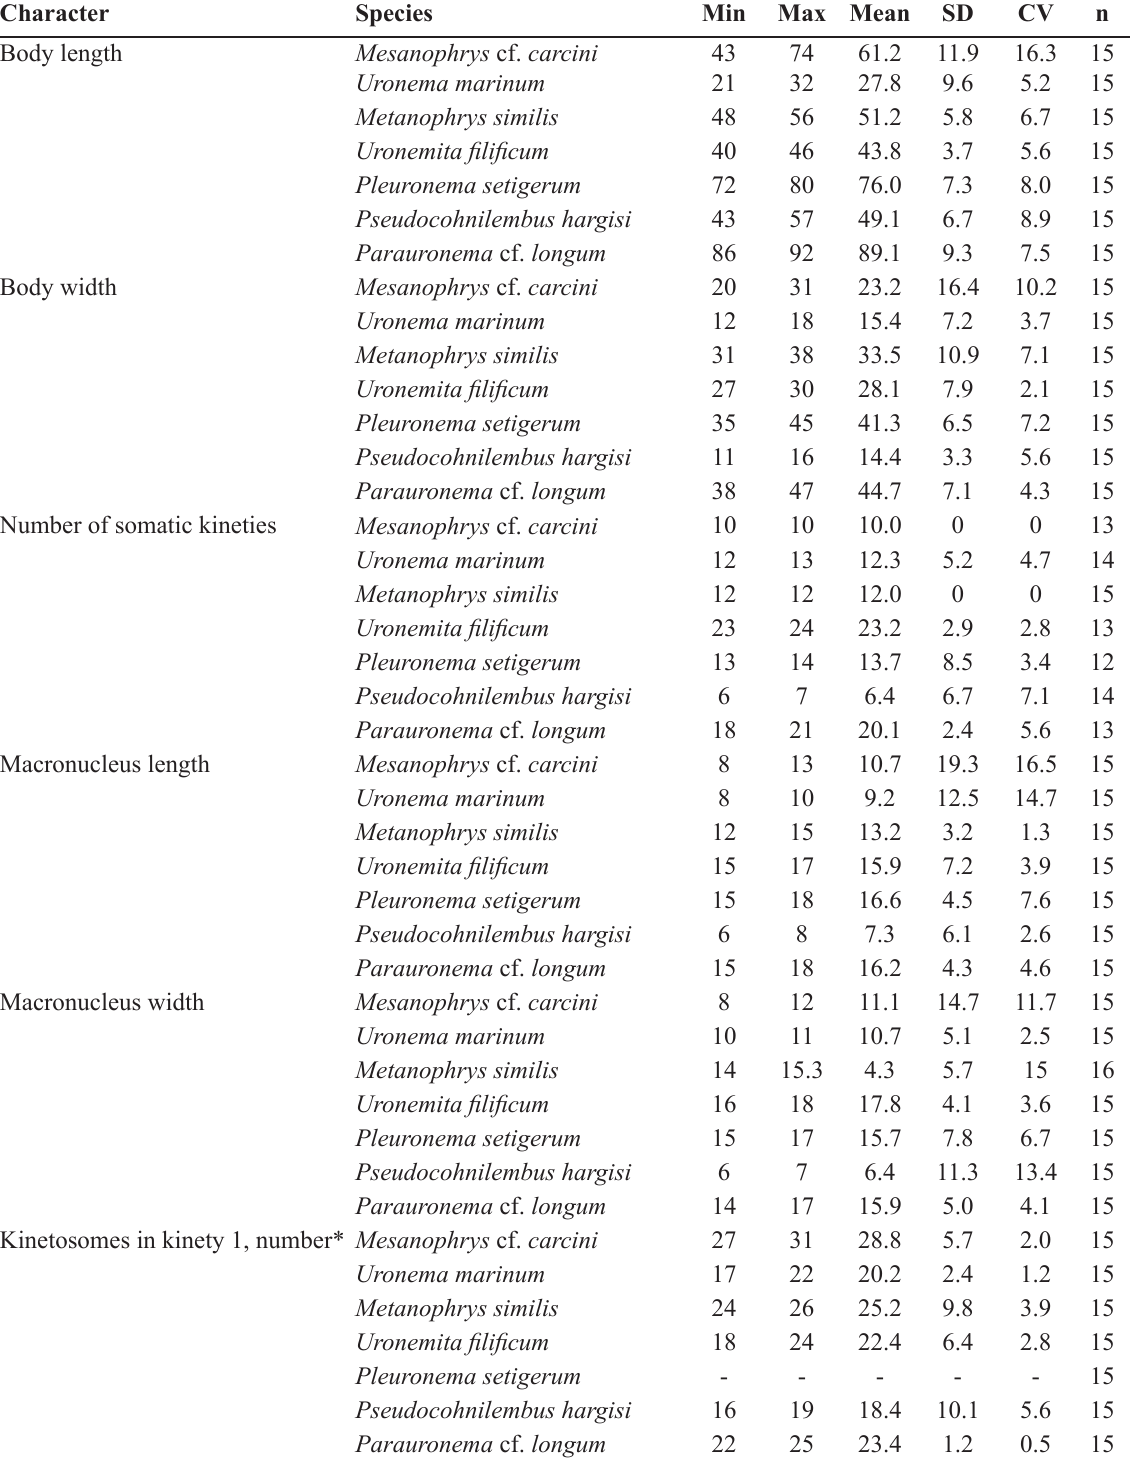
Table 1. Morphometric characterization of seven species from Alabama populations. Data based on silver carbonate-impregnated specimens. Measurements in µm. Abbreviations: CV = coefficient of variation in %; n = number of specimens investigated; Max = maximum; Mean = arithmetic mean; Min = minimum; SD = standard